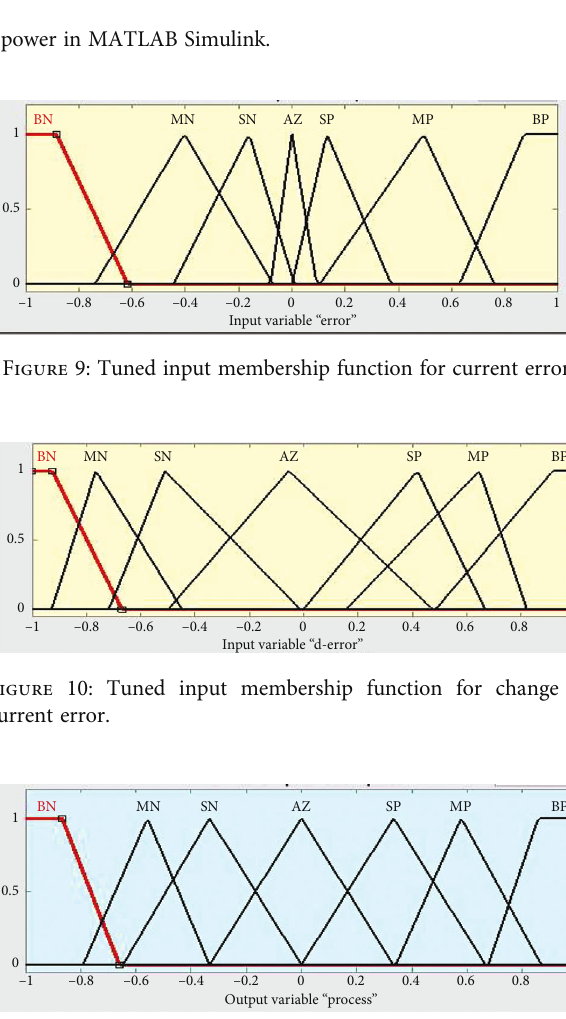
Figure 11: Tuned output membership functions for